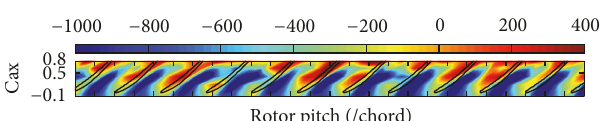
Figure 16: Pressure distribution within the blade passage for a section of the compressor. The units for the pressure are in [Pa], Cad is the axial tip chord, and the rotor pitch is a normalized parameter relative to blade